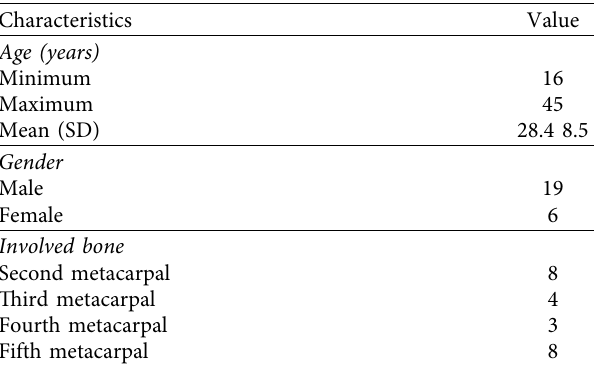
Figure 5: Functional outcome after K-wire removal with full range of motion and excellent functional outcome. Table 1: Demographic data.